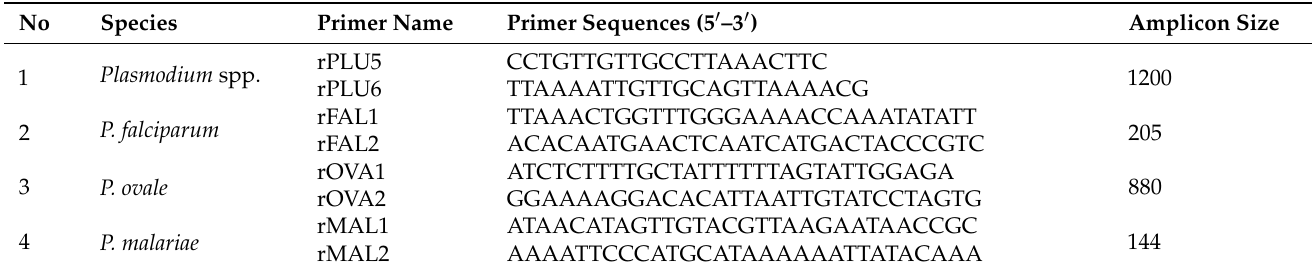
Table 1. Primers used in this